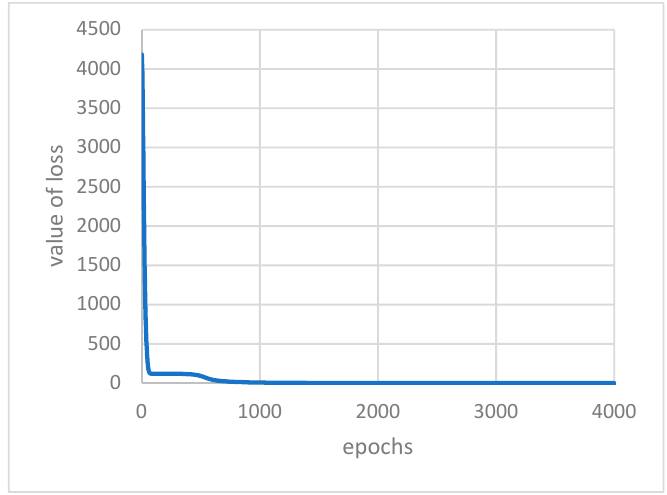
Figure 11. Value of loss with epochs in GRU-AE.